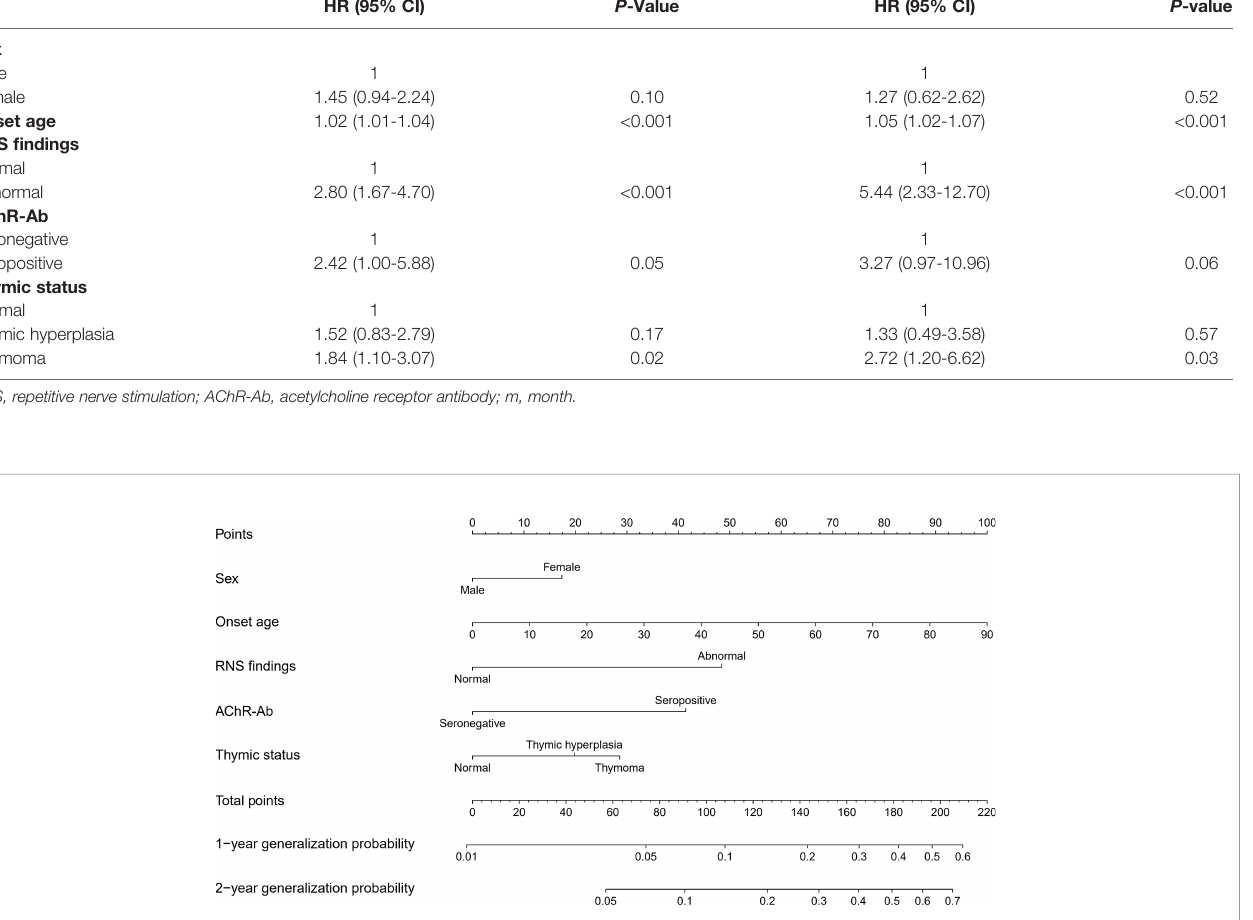
TABLE 2 | Multivariable HRs for association between predictive variables and generalization. Predictive variables